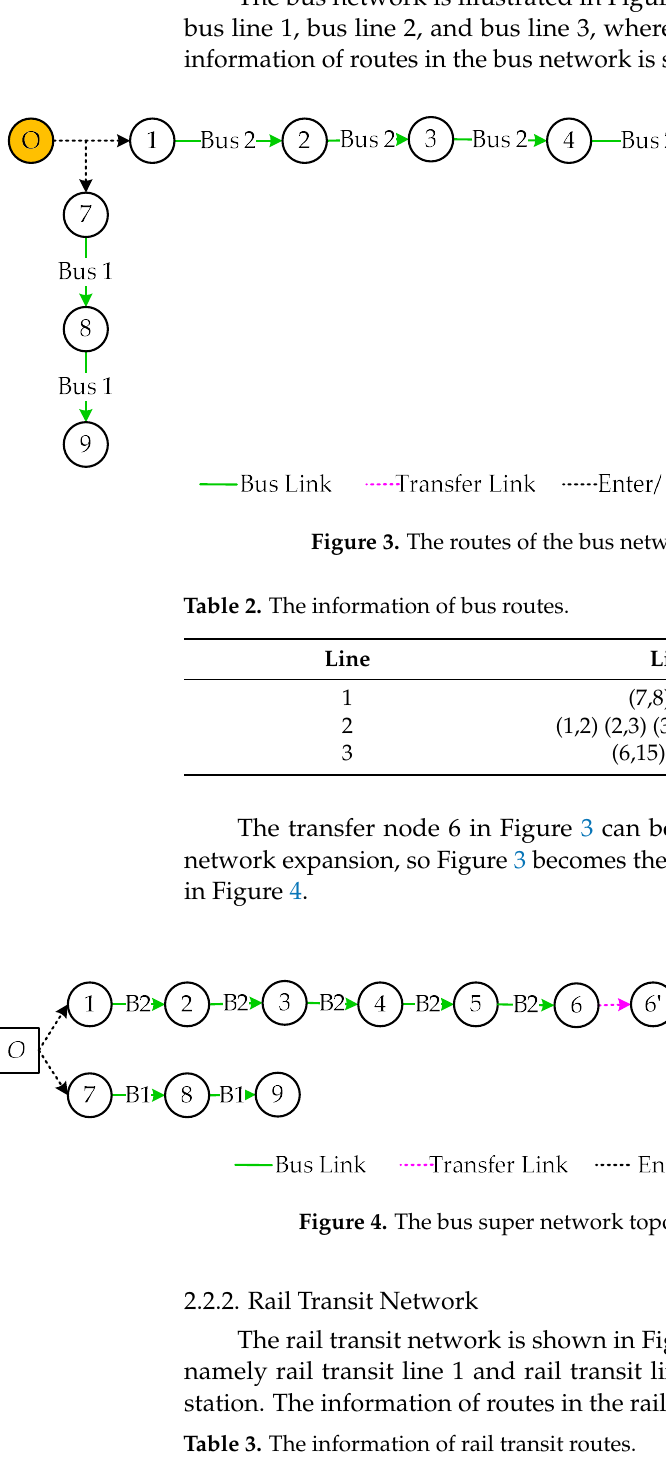
Figure 2. The diagram of the multimodal transportation network.